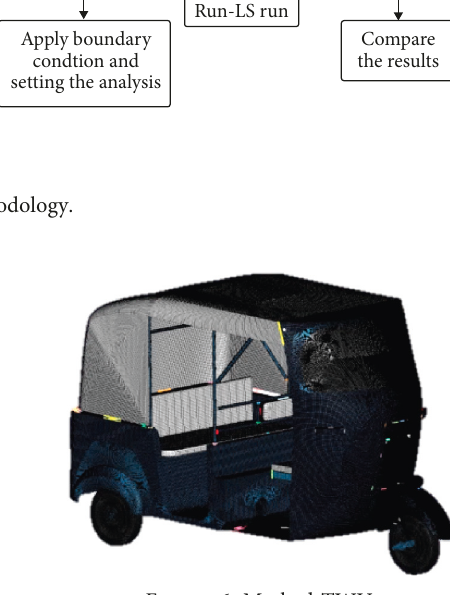
Figure 5: 3D modeling of TWV. Figure 6: Meshed